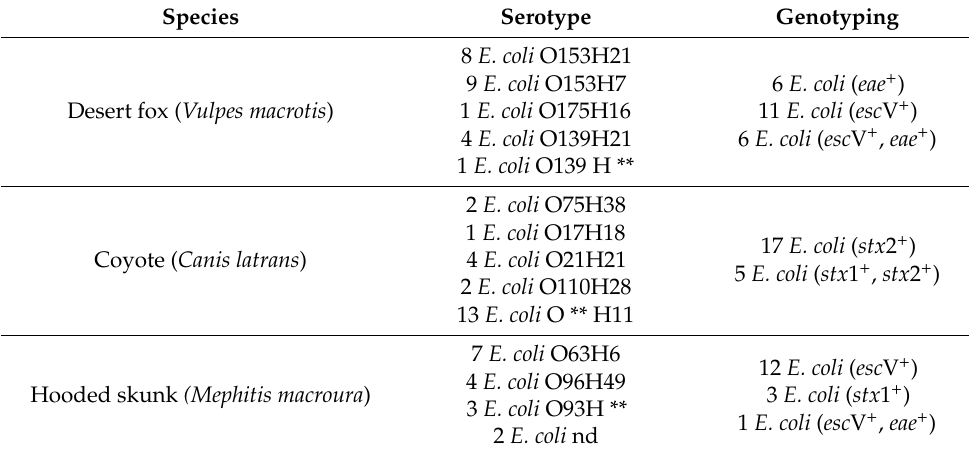
Table 3. E. coli strains isolated from carnivores. Species Serotype Genotyping